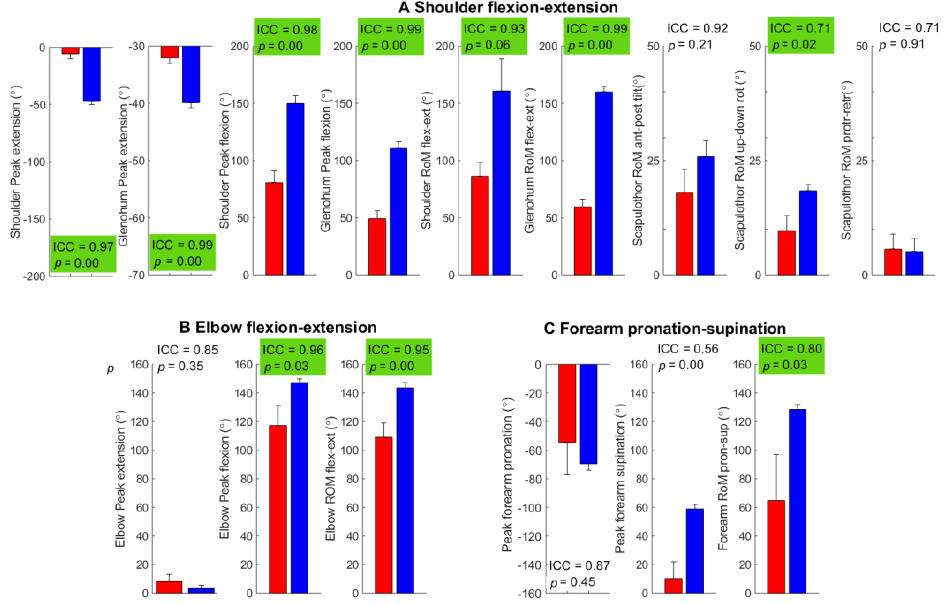
Figure 4. Outcome measures from the assessment of ( A ) shoulder and ( B , C ) elbow mobility. Group mean and standard error of mean are illustrated (BPBI: red left bar, control: blue right bar). ICC from test – retest reliability and p -values from t -tests are shown in the upper right corner of each subplot and are highlighted green for outcome scores with both good test – retest reliability (ICC > 0.75) and a significant group difference ( p < 0.05).